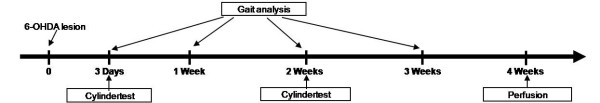
Experiment time line for gait analysis in 6-OHDA PD model in rats. Lesioned and control rat groups were prepared as described in materials and methods. Experimental groups were tested for motor deficits via automated gait analysis or via limb use asymmetry test (cylinder test) at indicated time points. Brains of animals were perfused at 4 weeks post-injection for histological analysis. *, measurement in striatal lesion groups only.